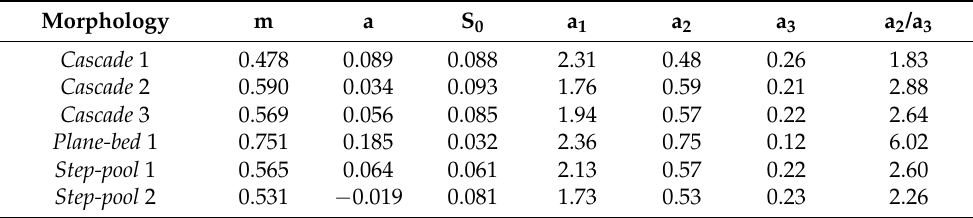
Table 5. NDHG exponents based on the proposed methodology.